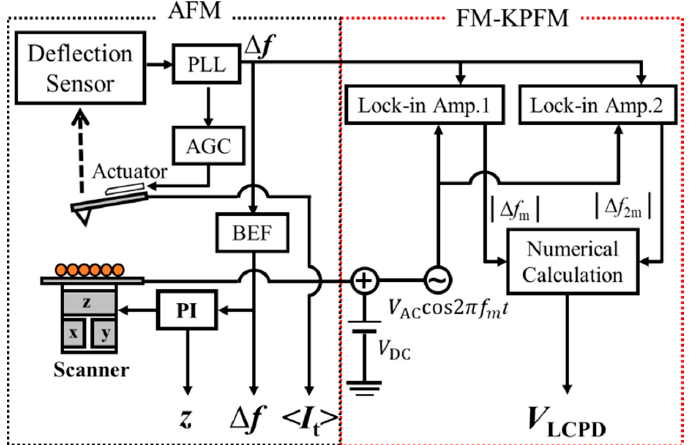
Figure 1. Experimental setup of AFM / FM-KPFM for simultaneous measurements of topography, < I t > and LCPD.